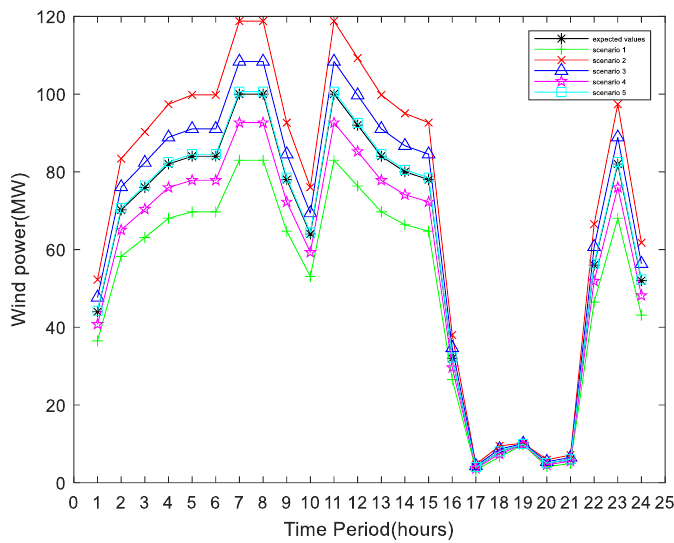
Figure 2. Sample points generated by the Latin hypercube method.